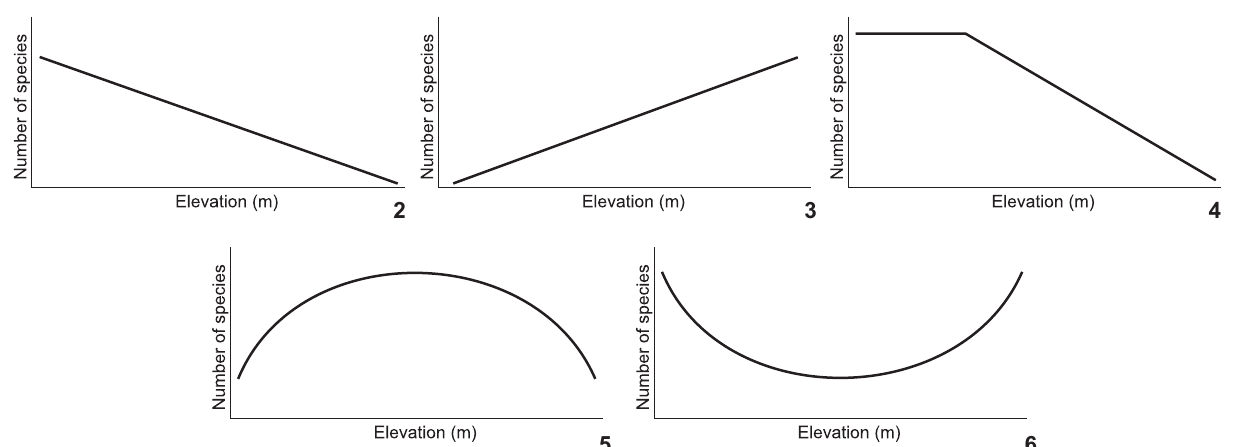
Figures 2-6. Elevational richness patterns based on empirical datasets at different Brazilian Atlantic Forest sites: (2) monotonic decreas- ing diversity, (3) increasing diversity, (4) constant at low elevations, (5) unimodal maximum at mid-elevations and (6) trough-shaped.